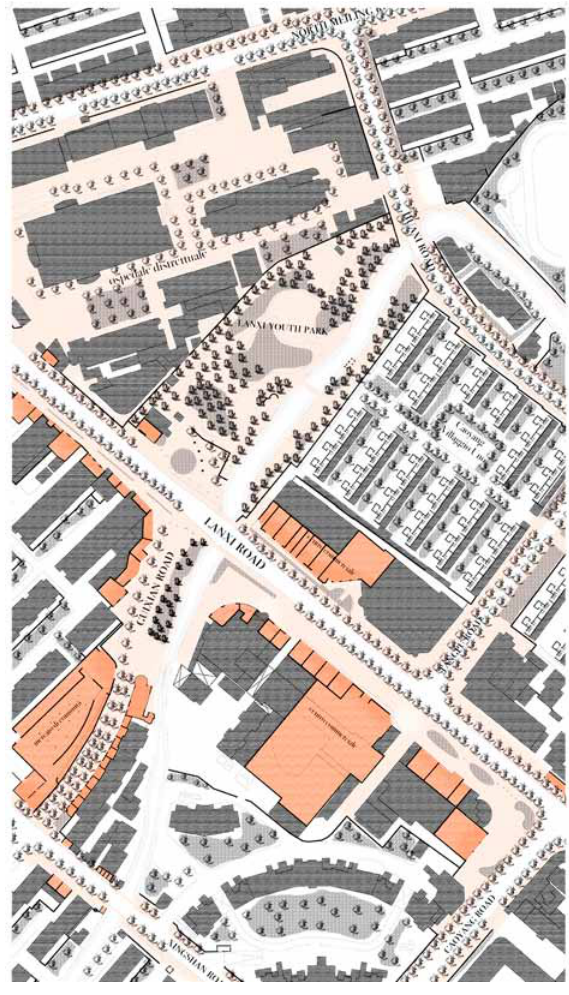
fig. 3. a fragment of Cao Yang represented in the style of nolli Map (Elaborated by the